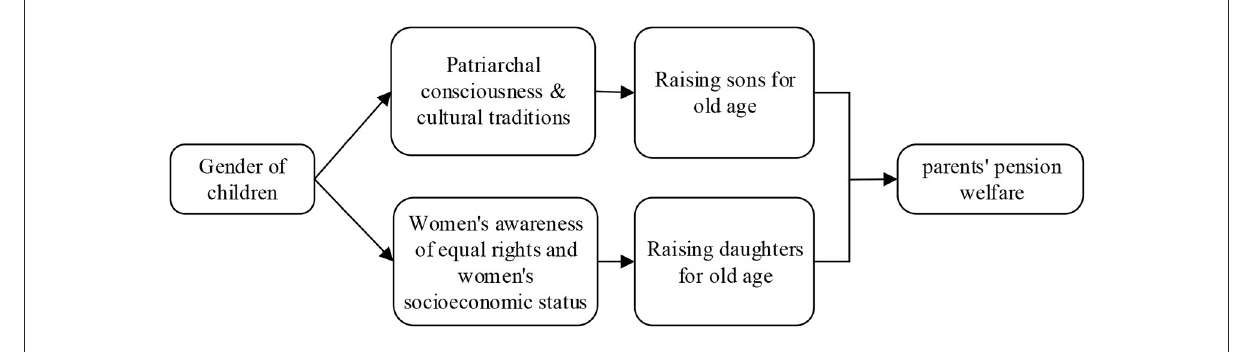
FIGURE1 Theoretical research framework